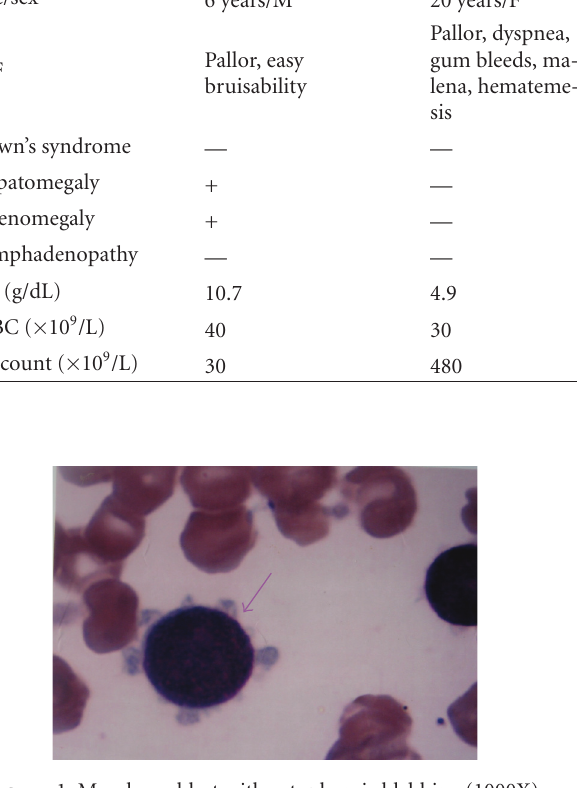
Figure 1: Megakaryoblast with cytoplasmic blebbing (1000X).